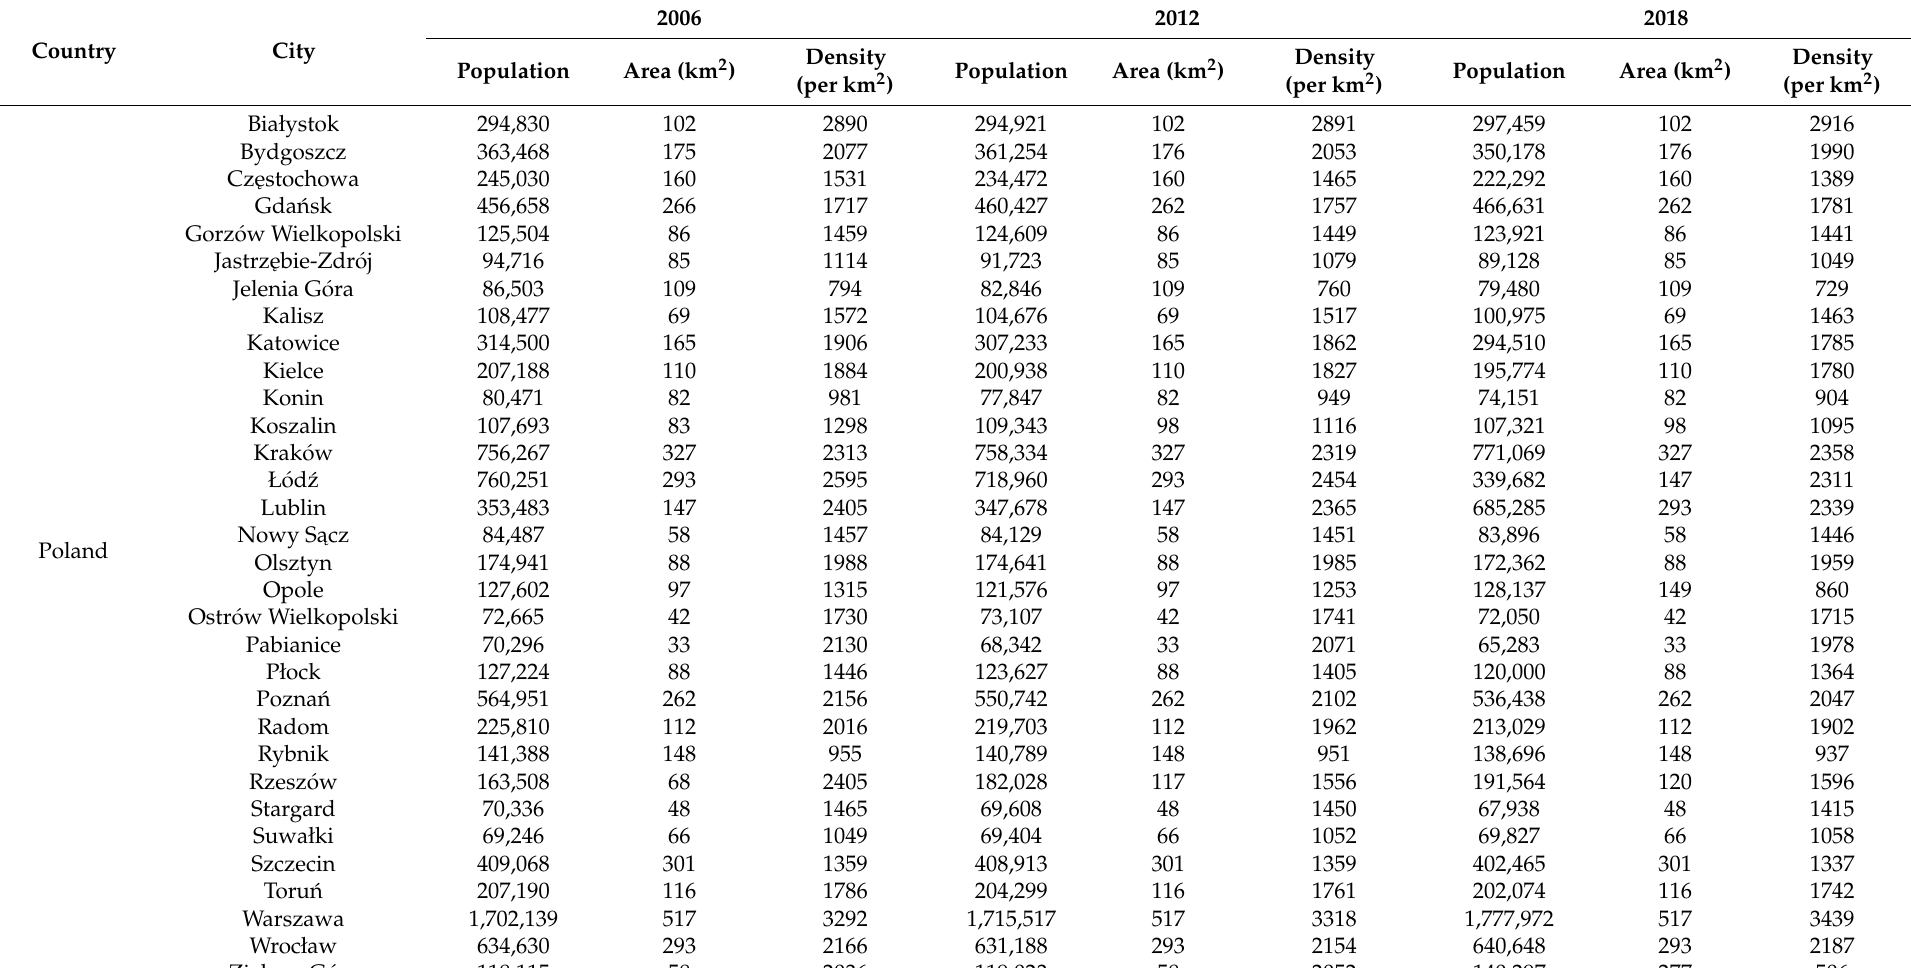
Table 2. Cities included in the study. The cities were selected based on their inclusion in the Urban Atlas Data in all the three periods considered (2000–2006, 2006–2021, and 2012–2018). In addition to their location, the table provides data on their population, area, and density of population, also used in the analysis.